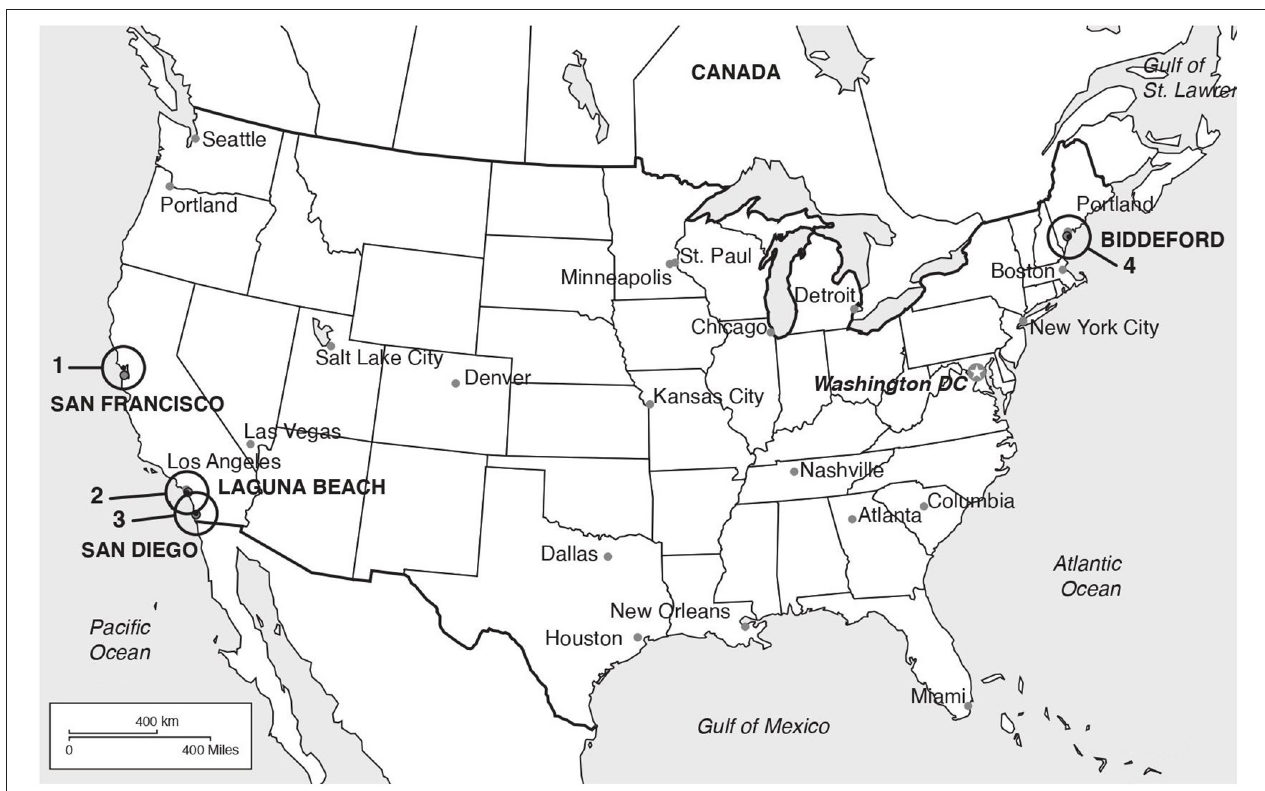
FIGURE 1 | Locations of the rehabilitation facilities where the animals were sampled. (1) The Marine Mammal Center (TMMC; Sausalito, San Francisco); (2) Pacific Marine Mammal Cente (PMMC; Los Angeles); (3) Sea World (San Diego); (4) Marine Animal Rehabilitation Center, University of New University of New England